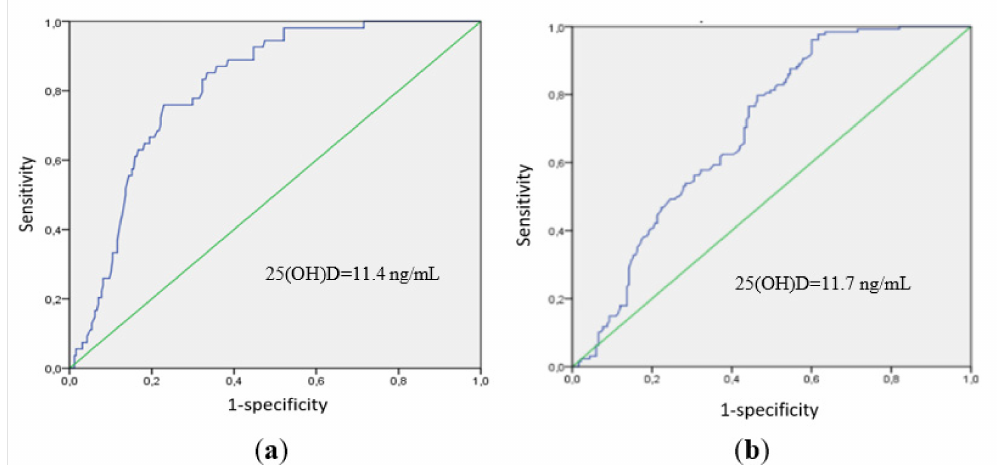
Figure 1. ROC analysis data: ( a ) the threshold for 25(OH)D levels associated with mortality was 11.4 ng/mL (AUC area = 0.811; sensitivity, 76%; and specificity, 77%; p = 0.003), and ( b ) the threshold for 25(OH)D levels associated with severe disease was 11.7 ng/mL (AUC area = 0.69; sensitivity, 76%; and specificity, 54%; p =